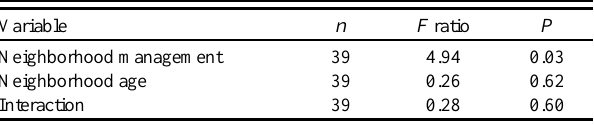
Table 2. Results from an analysis of covariance (ANCOVA) demonstrating how neighborhood age co-varies with neighborhood management (i.e., neighborhoods with and without a HOA) in explaining native bird diversity in Phoenix, Arizona. The insignificance of the interaction term indicates the homogeneity of the slopes was not rejected.